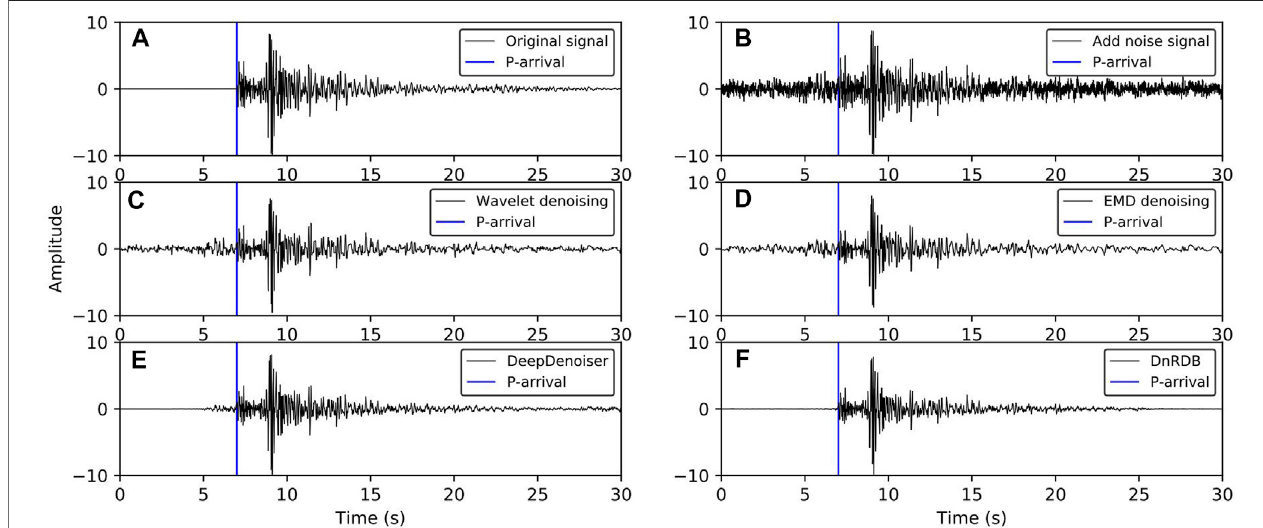
FIGURE 14 | Waveform comparison of the noise reduction results of various methods for SNR of 4dB. (A) Original data; (B) Noisy data; (C) Wavelet denoising result; (D) EMD denoising result; (E) DeepDenoiser denoising result; (F) Denoising result of the DnRDB model reported here.